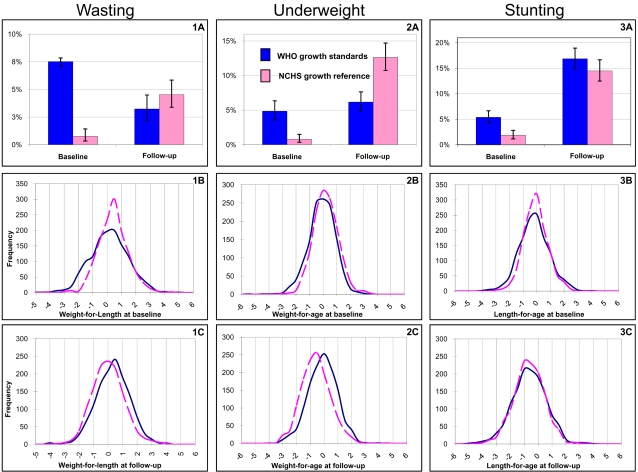
A - Prevalence [95% confidence intervals] of wasting (1A), underweight (1B) and stunting (1C) according to the growth reference used.B–C - Frequency distribution of nutrition indices in z-score at baseline (B) and follow-up (C) according to the growth reference used. The prevalence of malnutrition reported in (A) corresponds to the surface under the curve below -2 z-score.